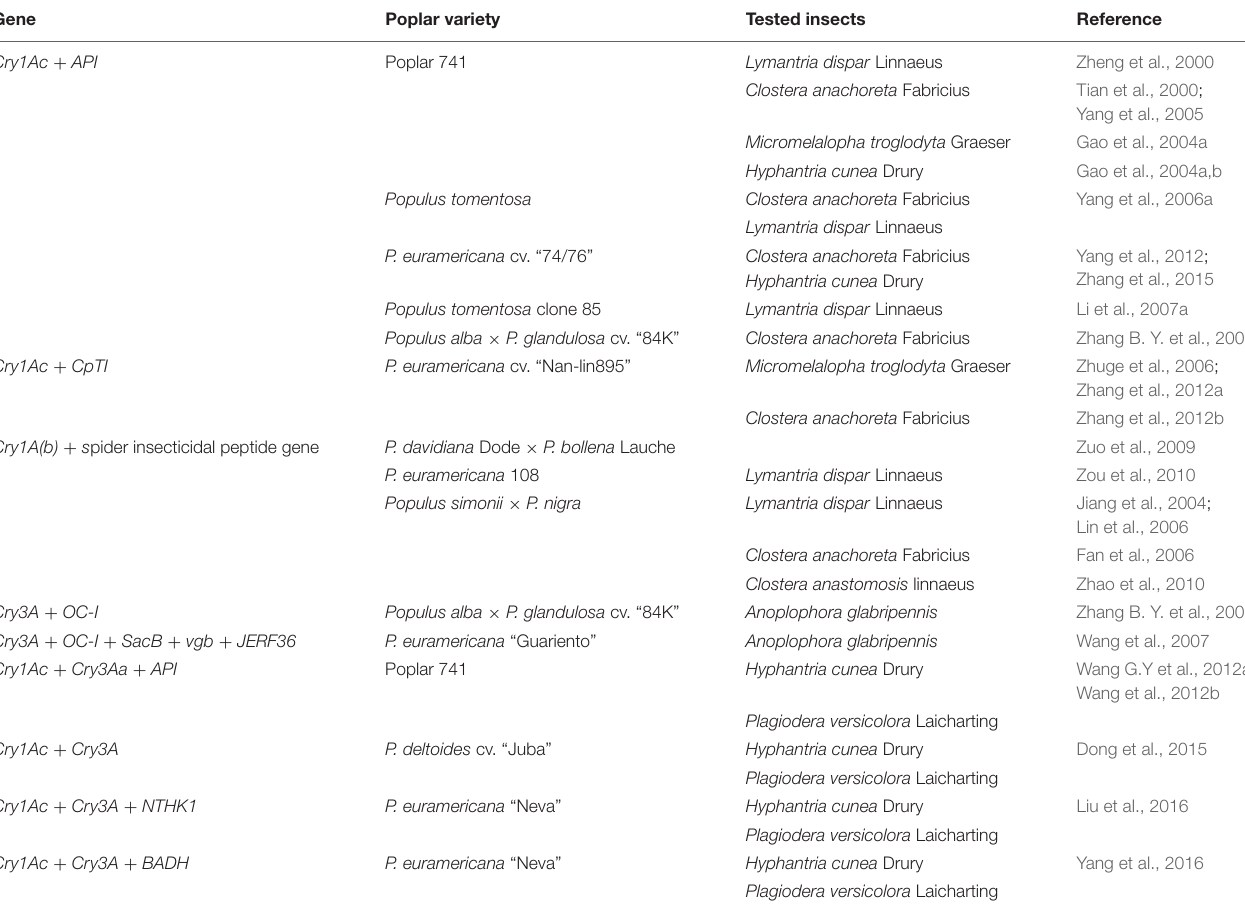
TABLE 2 | Multigene transformation of poplar varieties, and the insects used for testing, in China. Gene Poplar variety Tested